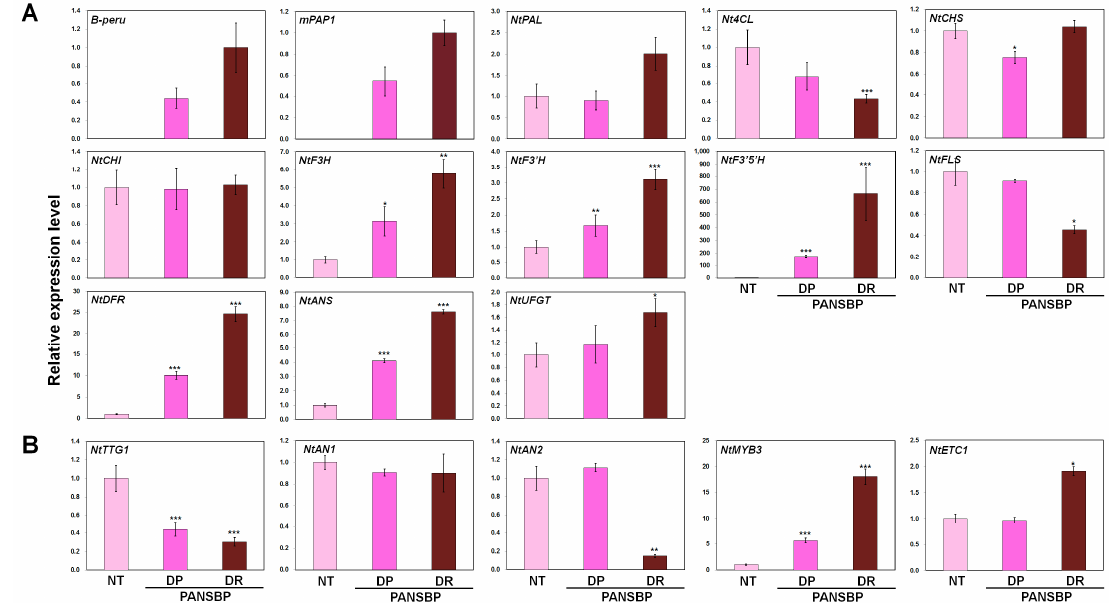
Figure 4. Expression profiles of anthocyanin structural and regulatory genes in NT and PANSBP transgenic tobacco petals. ( A ) Transcript abundance of the B-peru and mPAP1 transgenes and anthocyanin structural genes. The biosynthetic pathway genes evaluated include those encoding chalcone synthase ( NtCHS ), chalcone isomerase ( NtCHI ), flavanone 3-hydroxylase ( NtF3H ), flavonoid 3 (cid:48) -hydroxylase ( NtF3 (cid:48) H ), flavonoid 3 (cid:48) 5 (cid:48) -hydroxylase ( NtF3 (cid:48) 5 (cid:48) H ), flavonol synthase ( NtFLS ), dihydroflavonol 4-reductase ( NtDFR ), anthocyanidin synthase ( NtANS ), and UDP-glucose: flavonoid 3-O-glucosyltransferase ( NtUFGT ) as well as the upstream enzyme phenylalanine ammonia-lyase ( NtPAL ) and 4-coumarate-CoA ligase ( Nt4CL ); ( B ) T ranscript abundances of endogenous anthocyanin regulators. The tobacco glyceraldehyde 3-phosphate dehydrogenase ( GAPDH ) gene was used to normalize the total amounts of RNA for each assay. Bar colors are indicative of flower color phenotypes, pink represents NT; dark pink, PANSBP_DP; dark red, PANSBP_DR. All results represent mean values ± SD from three biological replicates. *, ** and *** indicate values that differ significantly from NT at p < 0.05, p < 0.01, and p < 0.001, respectively, according to a Student’s paired t -test.